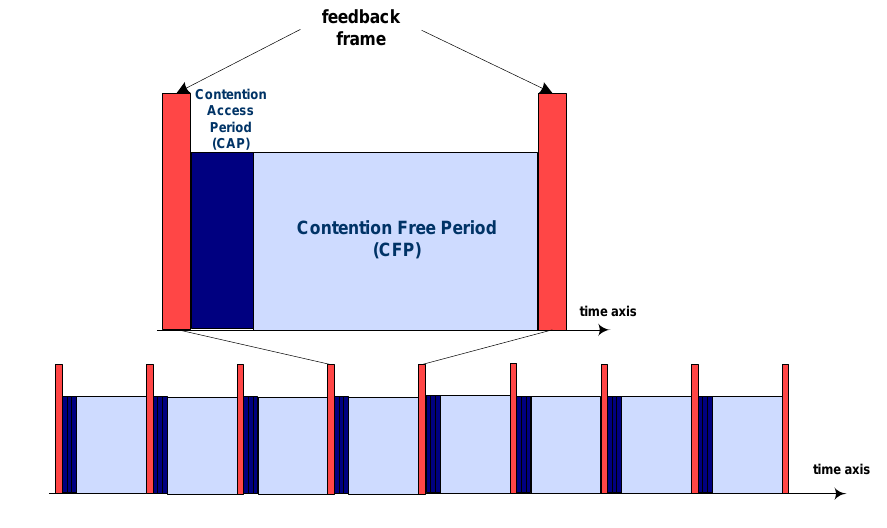
Figure 3. General superframe structure of a DQ MAC scheme.